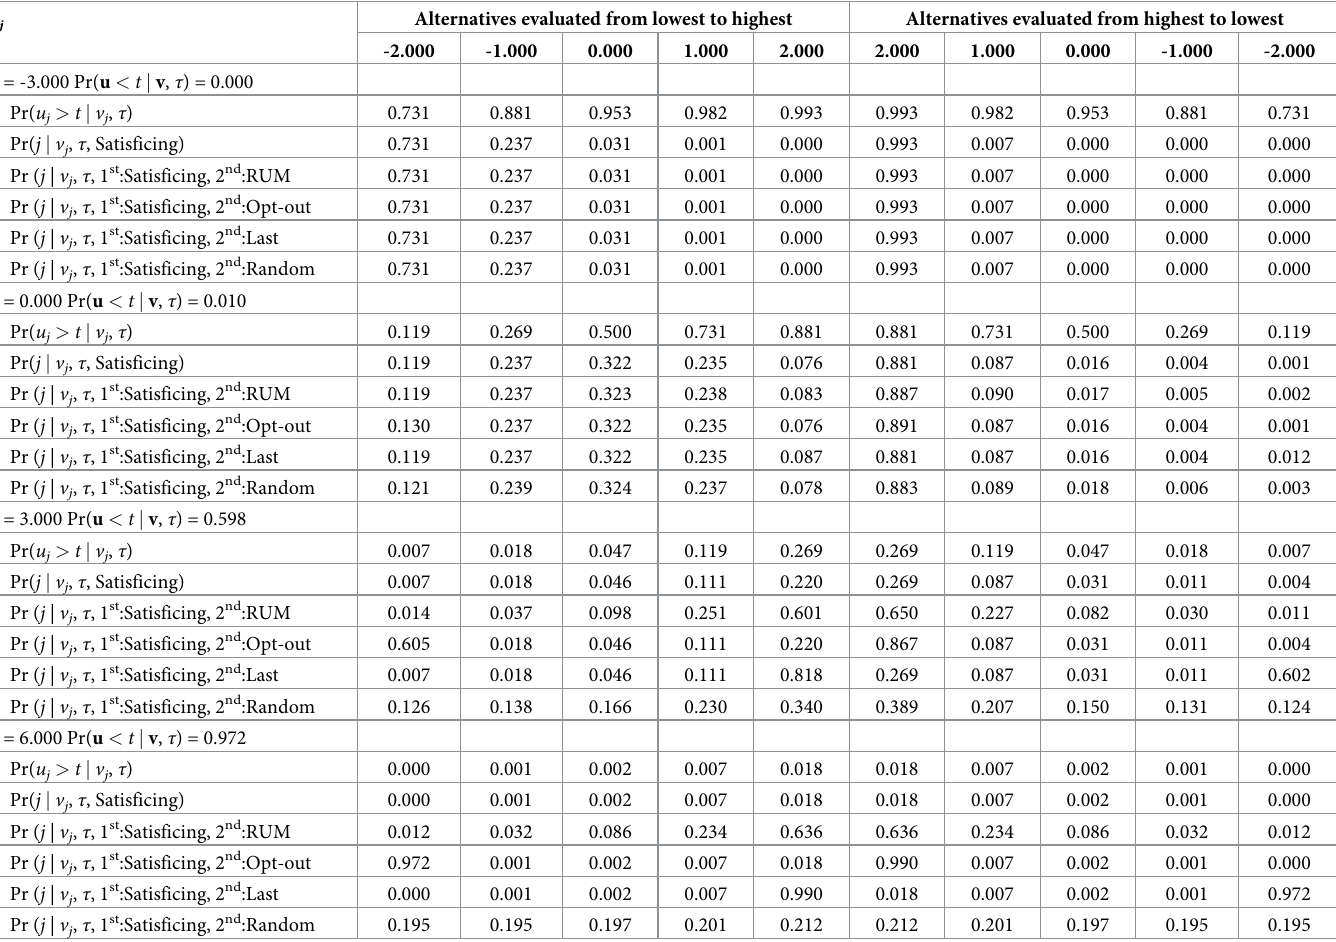
Table 1. Choice probability of an alternative being chosen under satisficing (for different satisficing thresholds and evaluation order of alternatives). v j Alternatives evaluated from lowest to highest Alternatives evaluated from highest to lowest -2.000